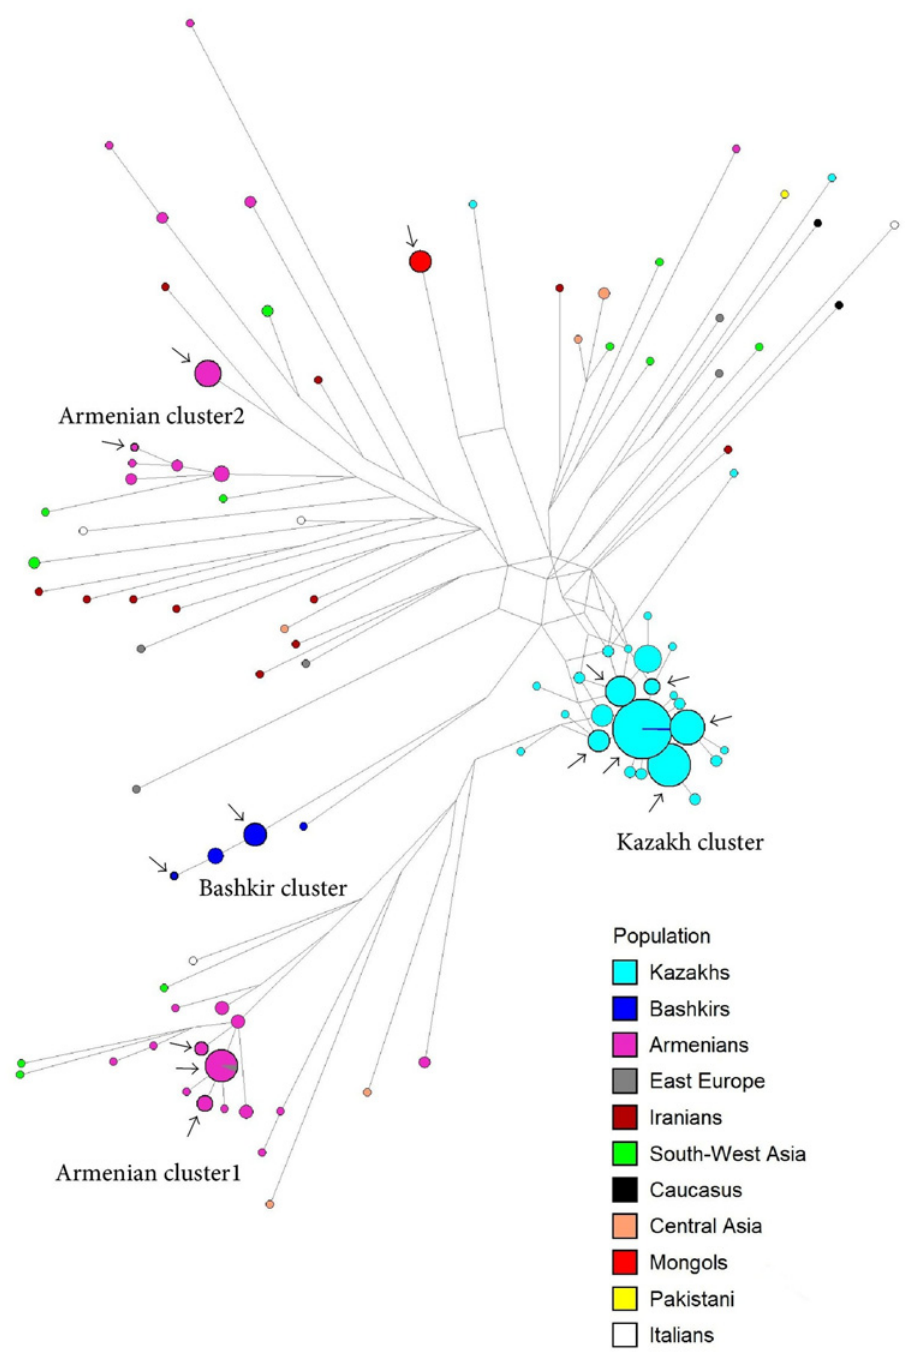
Fig 3. Network of Y-STR haplotypes within haplogroup G1. Arrows mark samples chosen for Y- chromosomal